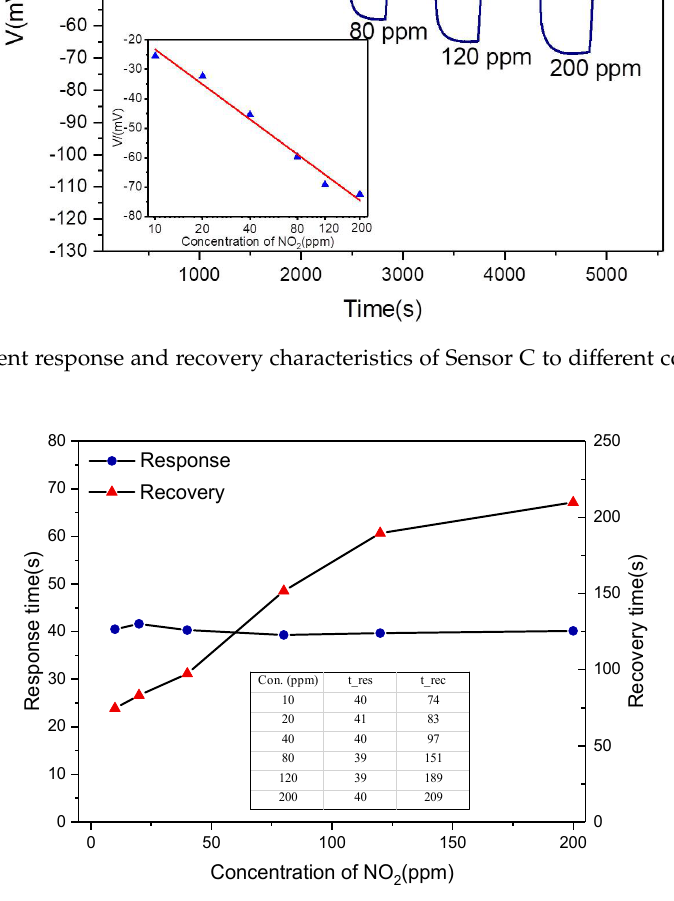
Figure 6. Transient response and recovery characteristics of Sensor C to different concentrations of NO 2 at 250 °C.